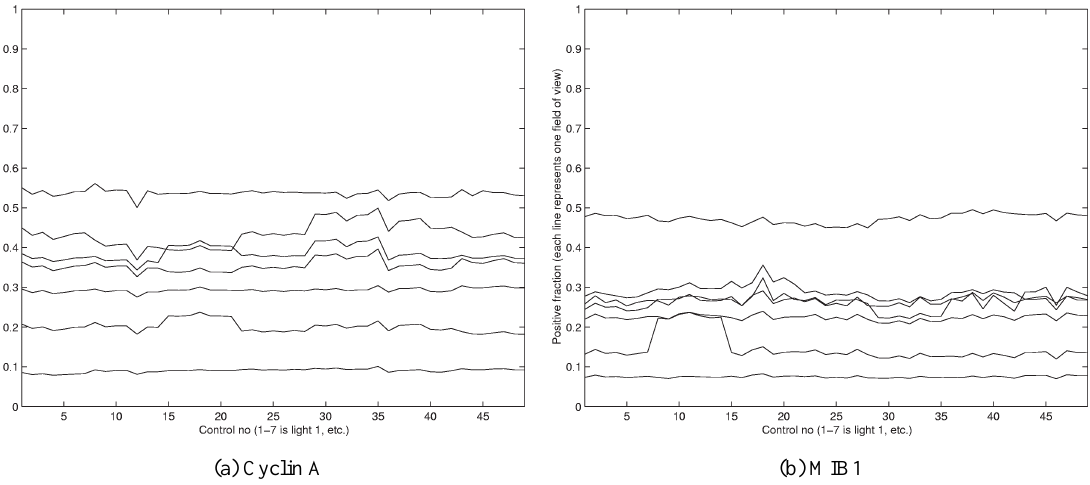
Fig. 9. Result for all measurements. Each line represents the same field of view. Each control is represented on the x -axis, where 1–7 comes from light setting 1, 8–14 from light setting 2, etc. This shows how the result varies due to both changes in light settings and control images. In the ideal case there should only be straight